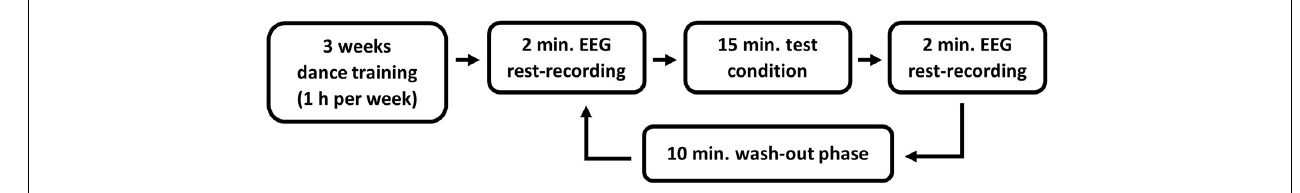
FIGURE 1 | Overview of the experimental